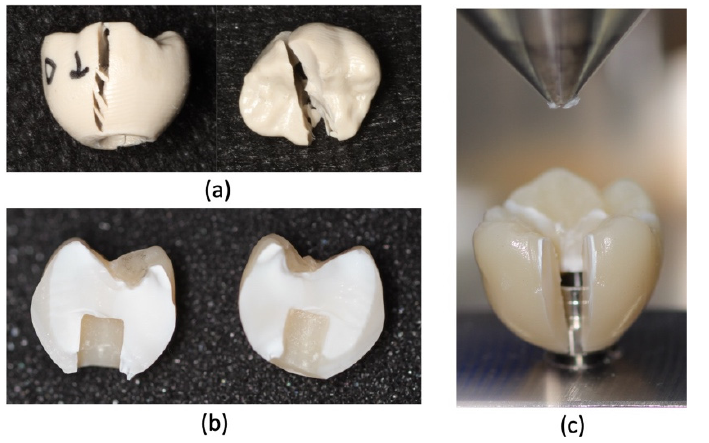
Figure 5. Fracture resistance results: ( a ) PEEK—Tecno Med Mineral ® , ( b ) composite resin—Lava Ultimate ® , and ( c ) PMMA—Temp Basic ® .